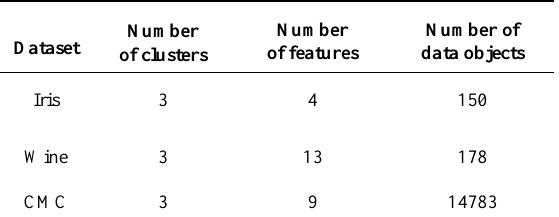
Table 1. Main characteristics of validation